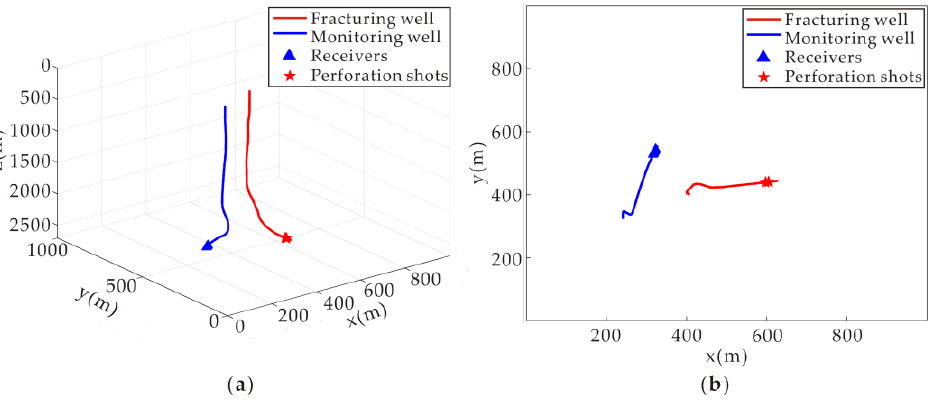
Figure 7. Downhole acquisition geometry of the real data set. ( a ) 3D display and ( b ) map view of acquisition geometry with the fracturing (red curve) and the monitoring (blue curve) wells, seven receivers (blue triangles) and two perforation shots (red pentagram). The x -, y - and z -axes represent the East, North and depth directions, respectively.